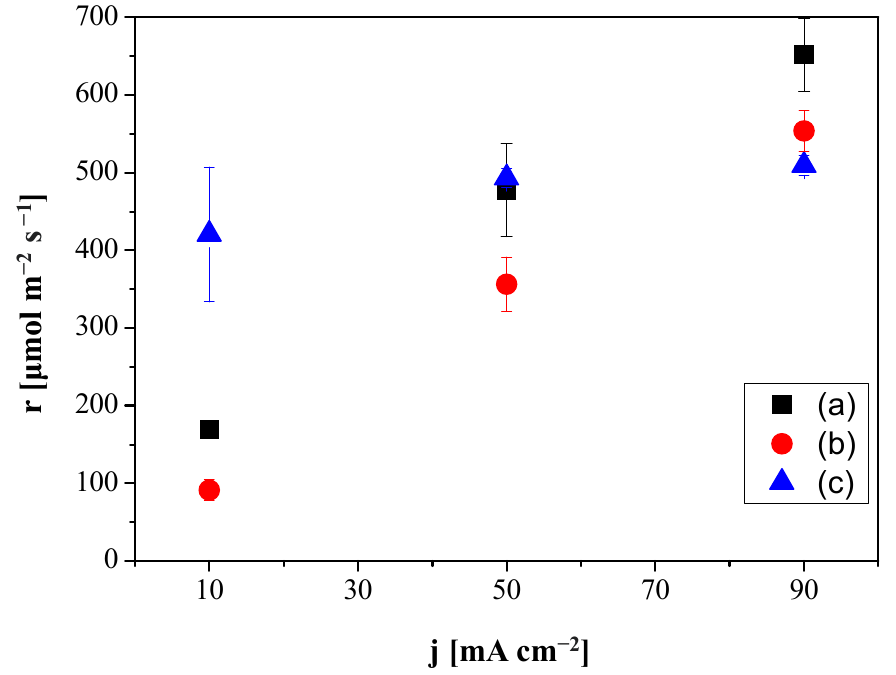
Figure 3. Production molar rates of ethylene generation as a function of applied current density for the Fumatech MEA (FAA-3 AEM and Cu:Fumion GDE) (a), the Sustainion MEA (Sustainion AEM and Cu:Sustainion GDE) (b) and the MEA composed by the Sustainion AEM and the Cu:CS GDE (c).